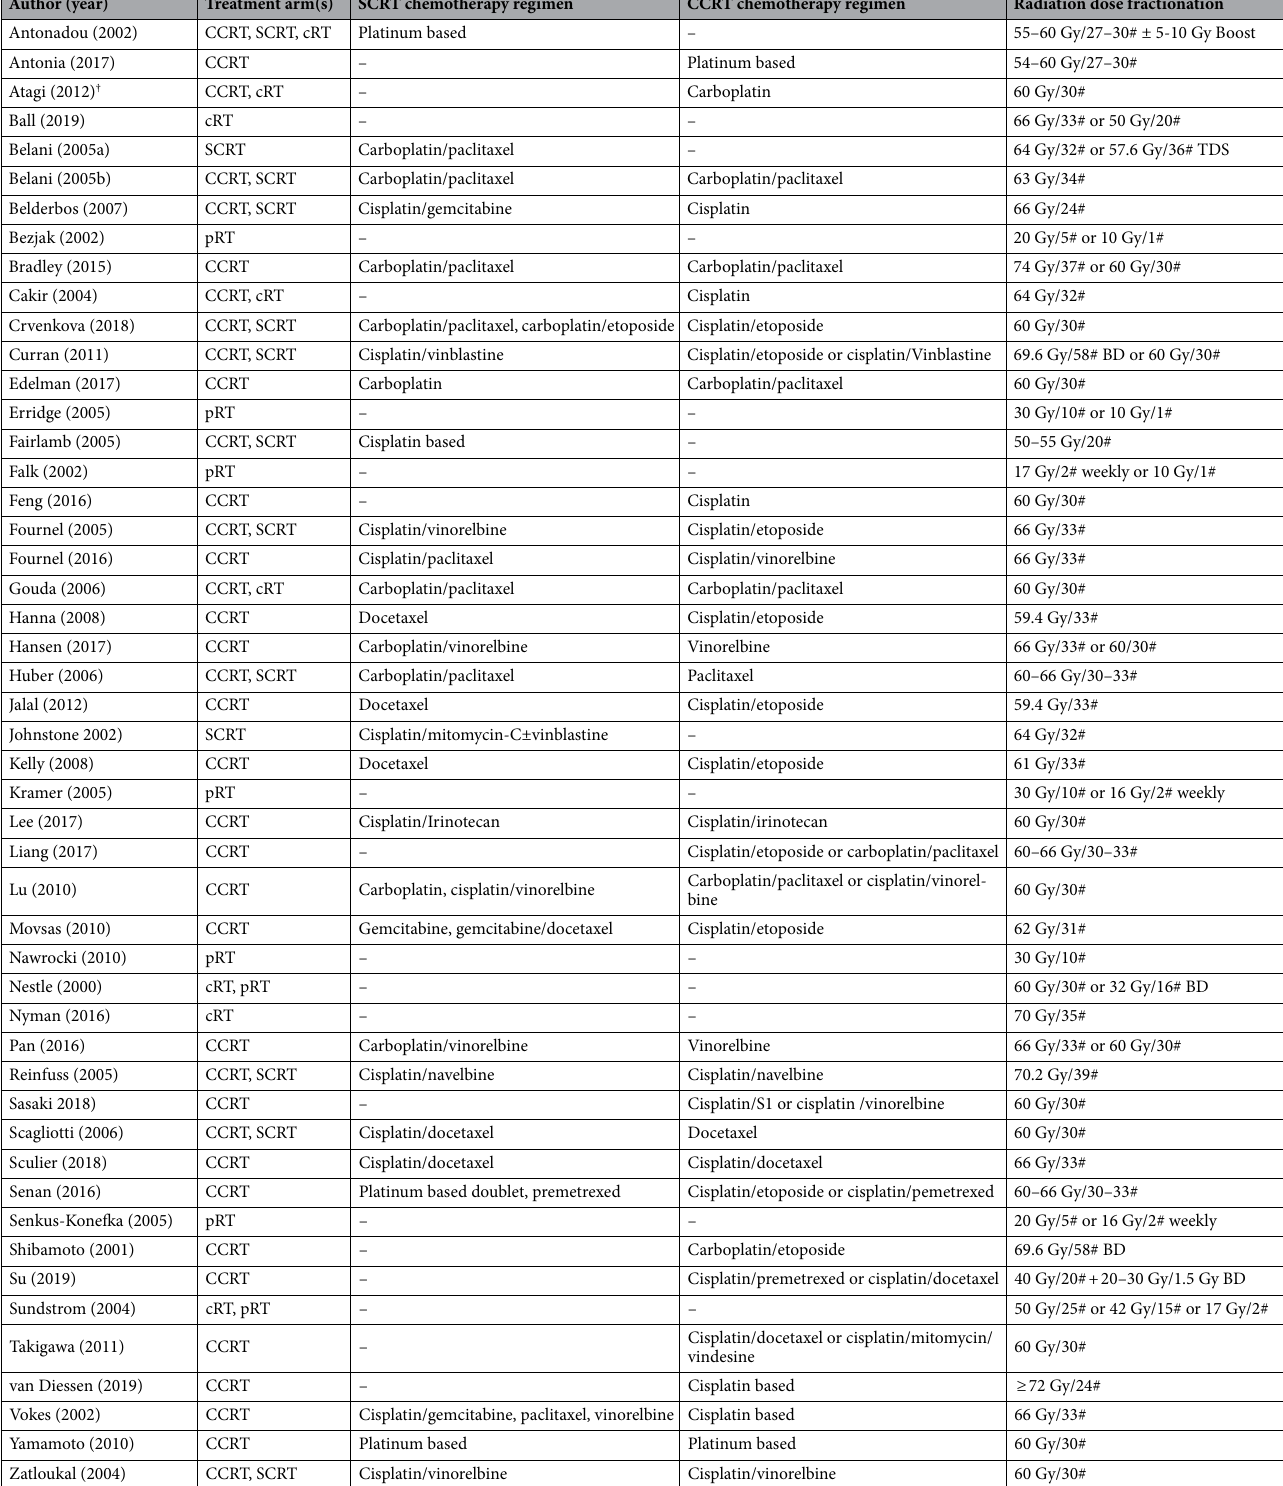
Table 2. Treatment characteristics of included trials. † Updated in 2018, includes censored cases. Not available. Multi-Modality Protocol. pRT—Palliative Radiotherapy. cRT—Curative Radiotherapy without chemotherapy. SCRT—Sequential chemoradiotherapy (induction or consolidation chemotherapy). CCRT—Concurrent chemoradiotherapy (with or without sequential